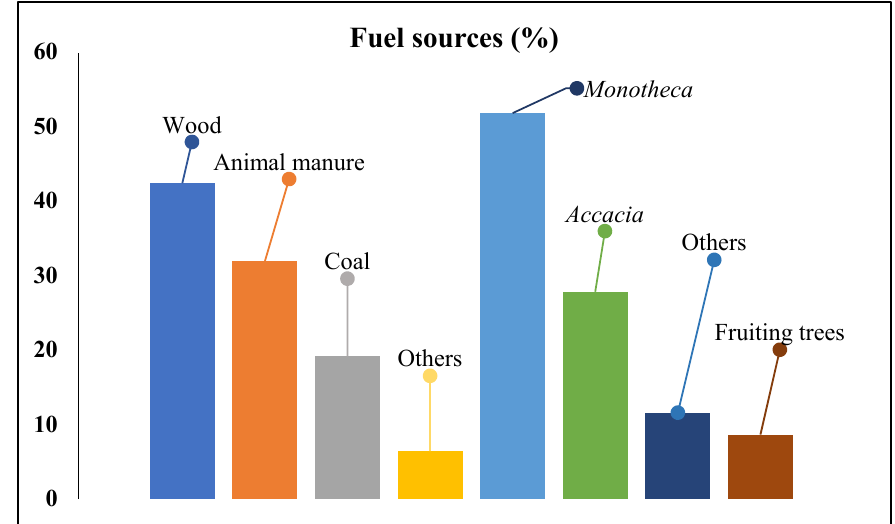
Figure 8. Different sources (column 1 to 4) used as a fuel material in households. Types of trees (column 5–8) consumed as fuel material.